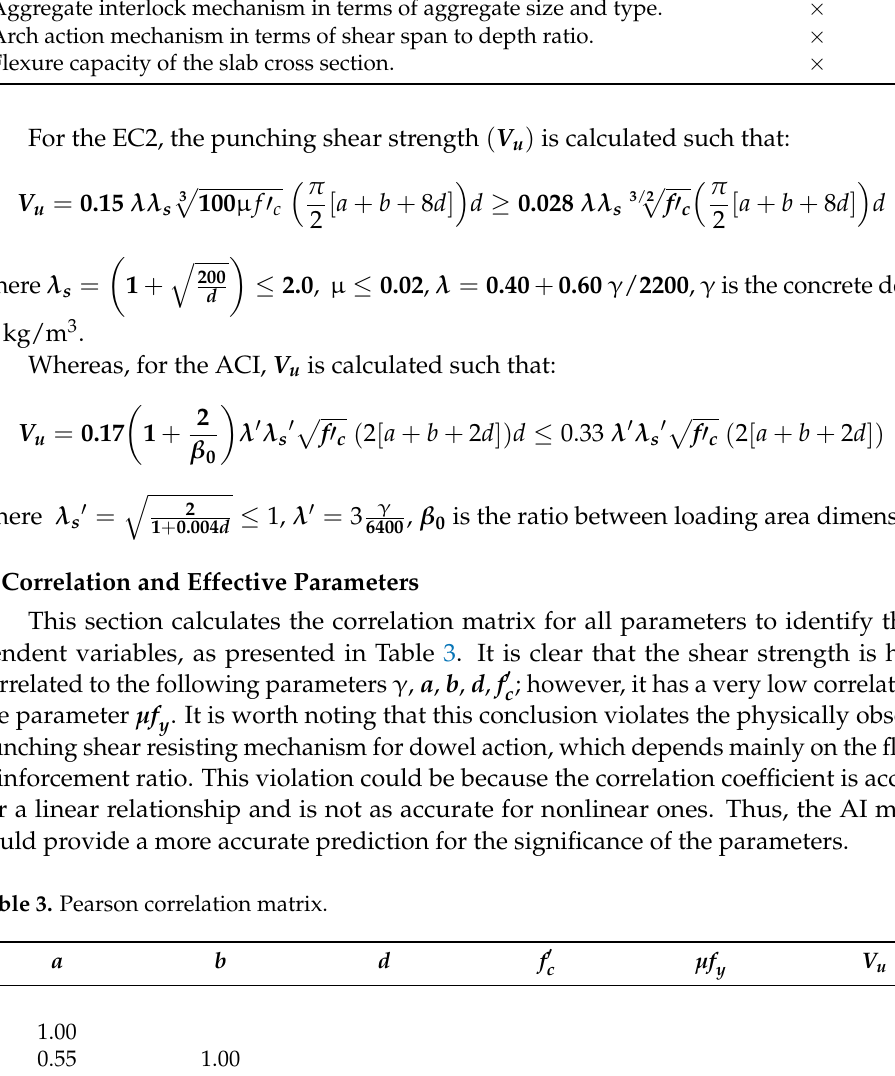
Table 2. Comparison between the parameters included by each of the selected models. Mechanism EC2 ACI Friction across crack in terms of f (cid:48) c . Dowel action mechanism in terms of µ . Concrete type in terms of γ . Column dimension in terms of a, b × × Direct shear mechanism in terms of compression zone depth in the strength. × × Size effect in terms of d .